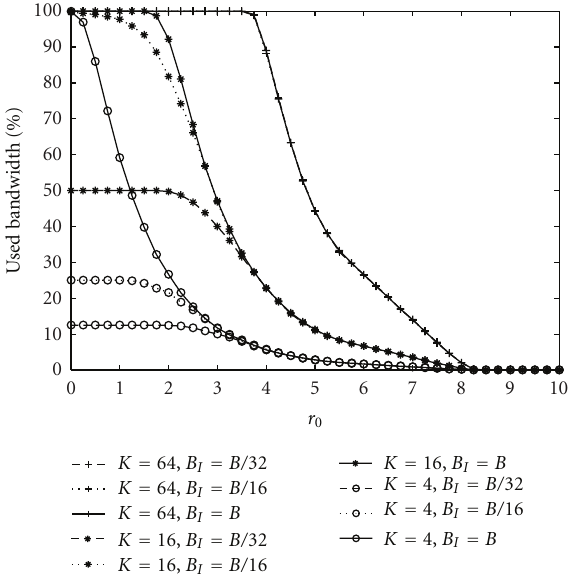
Figure 5: The percentage of used bandwidth versus the tax rate for SelBM; two-path channel